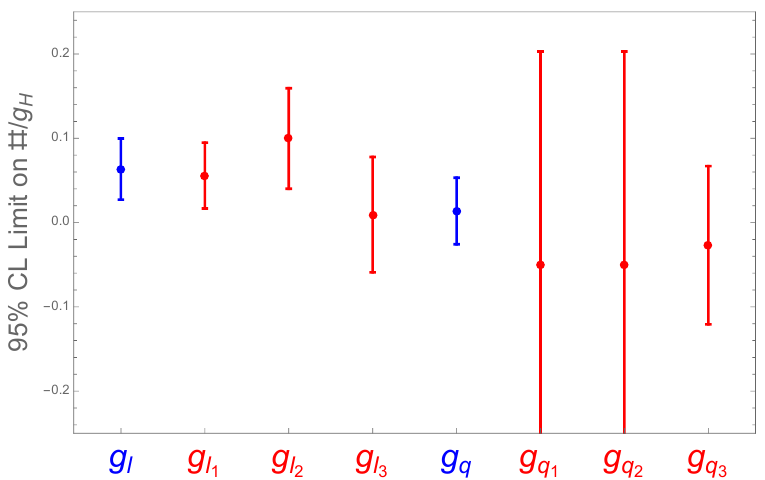
Figure 3 . Comparison of the limits on the parameter space of the SU(2) vector resonance model in the U(3) q U(3) l (cid:13)avour universal (blue) and (cid:13)avour generic (red) cases. We display the 95% CL (cid:2) con(cid:12)dence intervals for the resonance couplings to the SM fermions g f the Higgs g H , see eq. (5.3). In the (cid:13)avour universal case we have g f